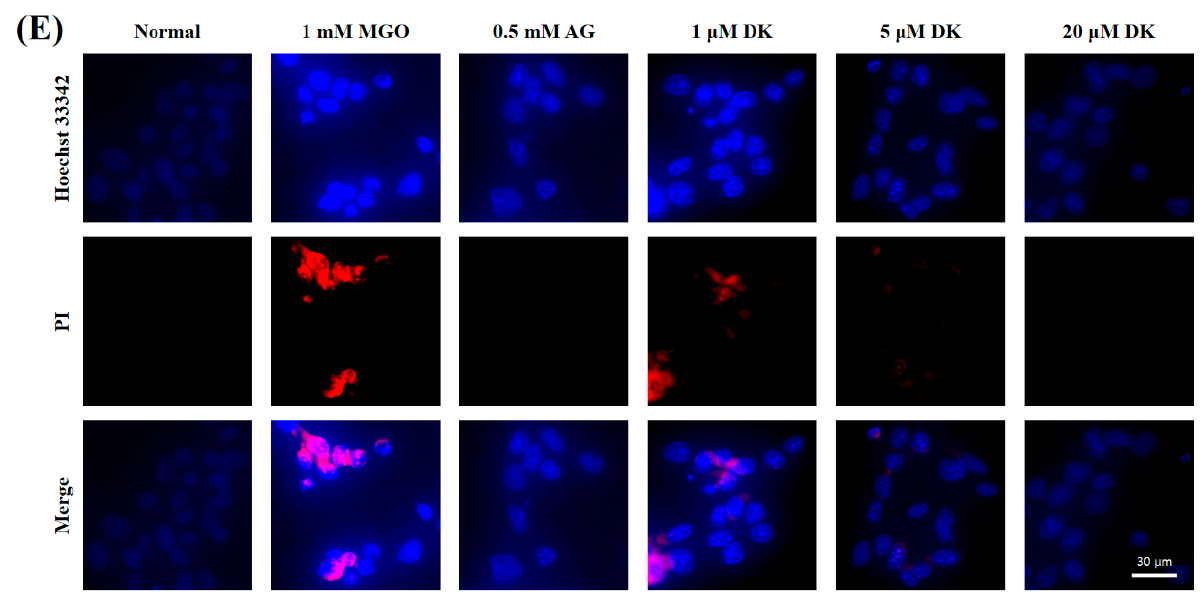
Figure 4. Antiapoptotic ability of DK on MGO-induced mouse glomerular mesangial cells. Cells were pretreated with DK (1, 5, and 20 µ M) or AG (0.5 mM) for 1 h. Then, 1 mM MGO was added and incubated for 23 h. Total apoptotic cell death of mouse glomerular mesangial cells was determined using Annexin V & Dead Cell Assay Kit (Luminex, TX, USA). ( A ) The results of analyzing total apoptotic cell death using annexin V and PI double staining are shown in dot plots.; ( B ) The bar graph presents the percentage of total apoptotic cells (early apoptosis and late apoptosis); ( C ) Dot plots present the results of analyzing caspase 3/7; ( D ) The bar graph exhibits the percentage of caspase 3/7 dependent apoptotic cell death in mouse glomerular mesangial cells; ( E ) Representative images of Hoechst 33342/PI double staining. All data are expressed as mean ± standard deviation ( n = 3) (*** p < 0.001 vs. nontreated cells and ### p < 0.001 vs. MGO-treated cells).